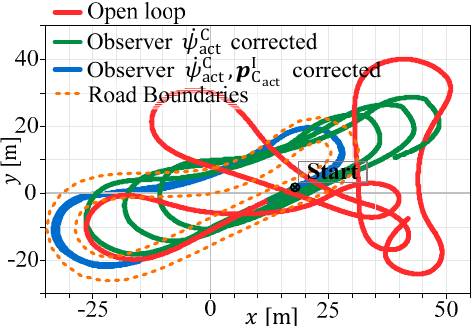
Figure 16. Comparison of different measurement incorporations.